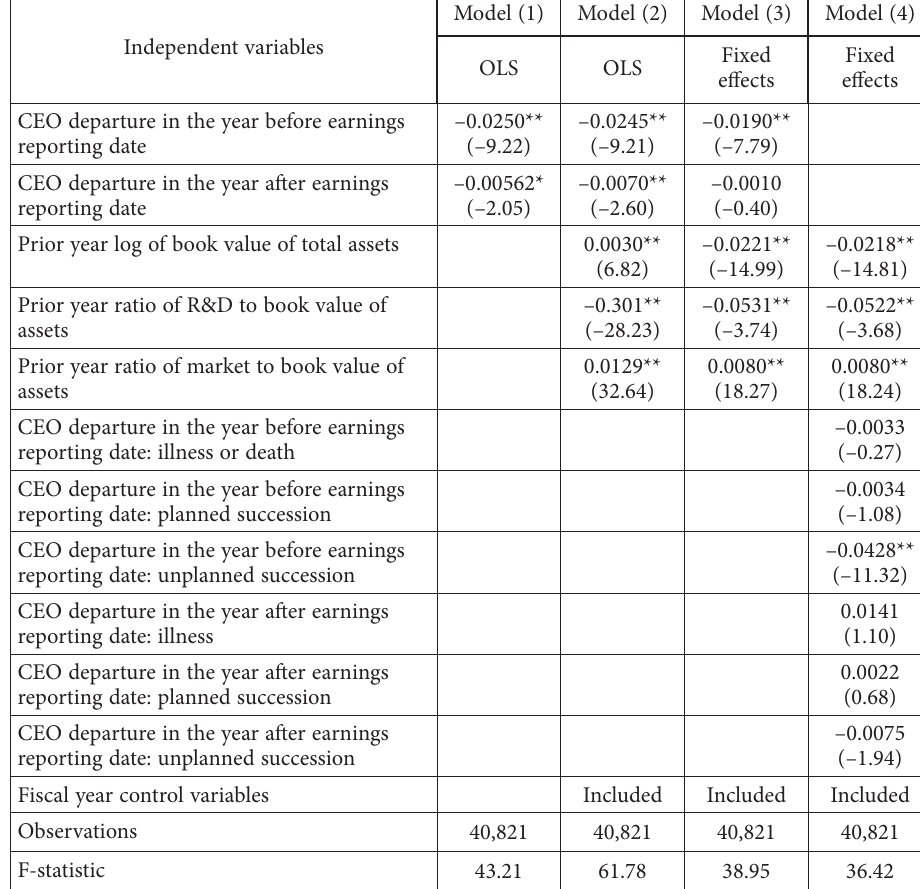
Table 4. Relative return on assets surrounding departures of